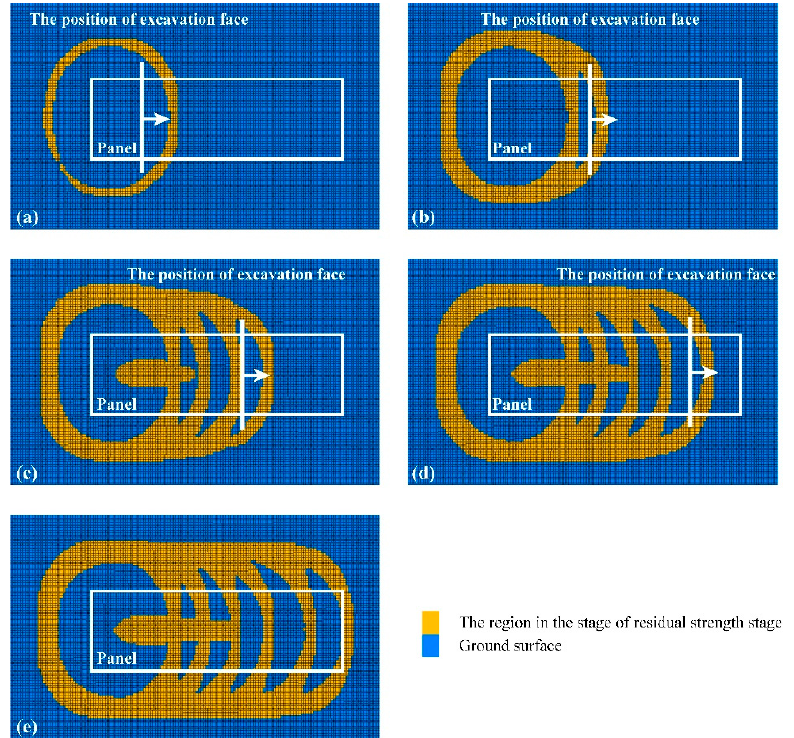
Figure 17. Top view of surface damage (( a ) 200 m, ( b ) 400 m, ( c ) 600 m, ( d ) 800 m, ( e ) 1000